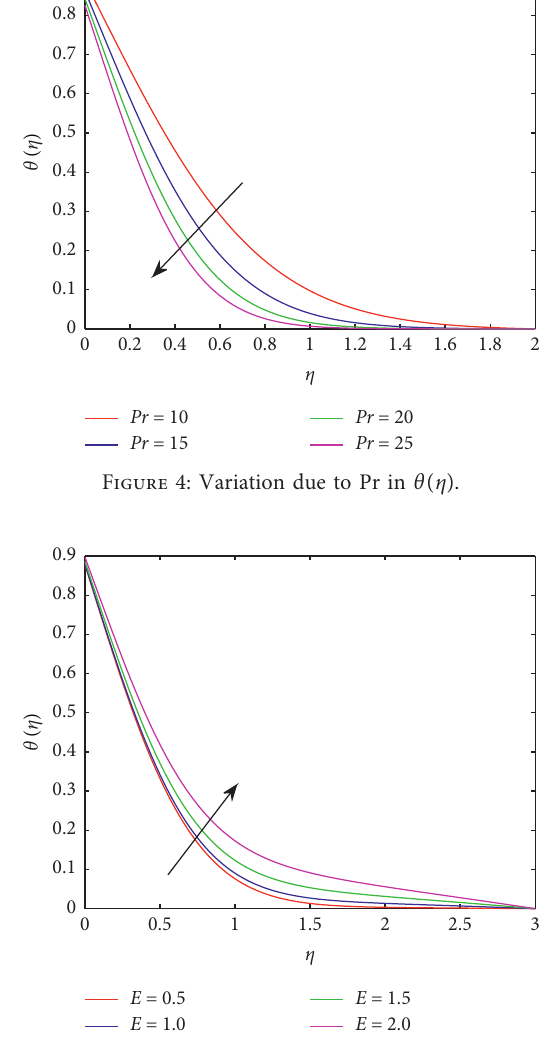
Figure 5: Variation due to E in θ ( η )